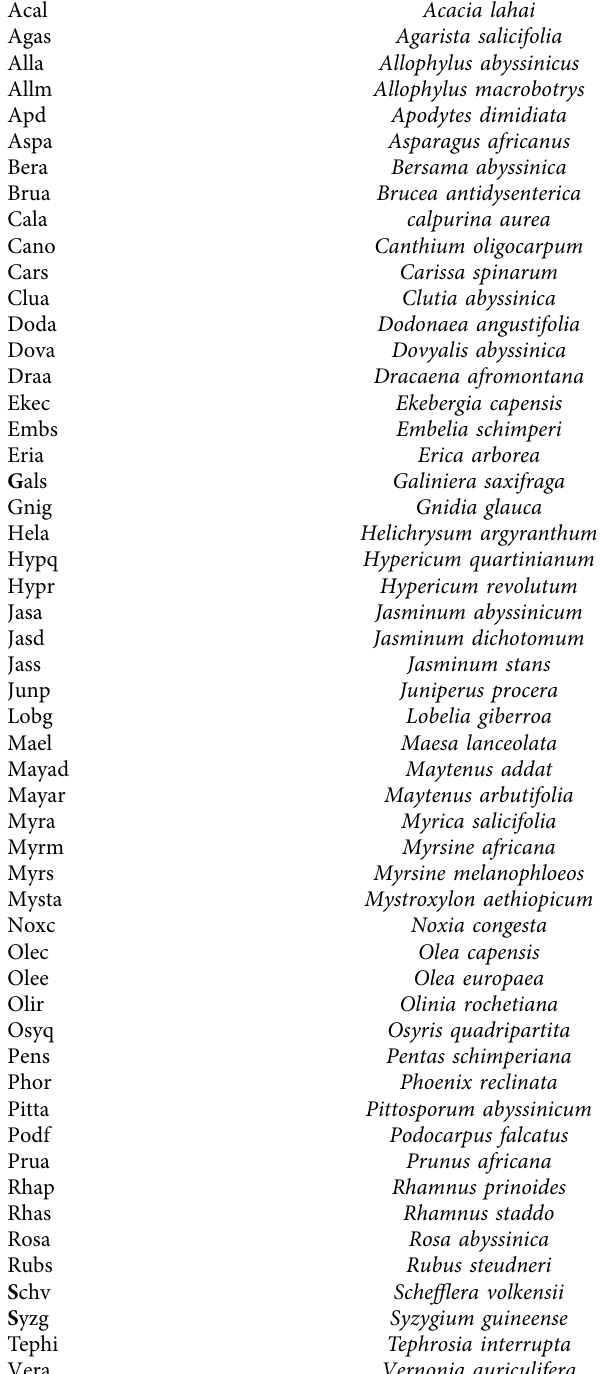
Table 5: Abbreviations used in NMDS